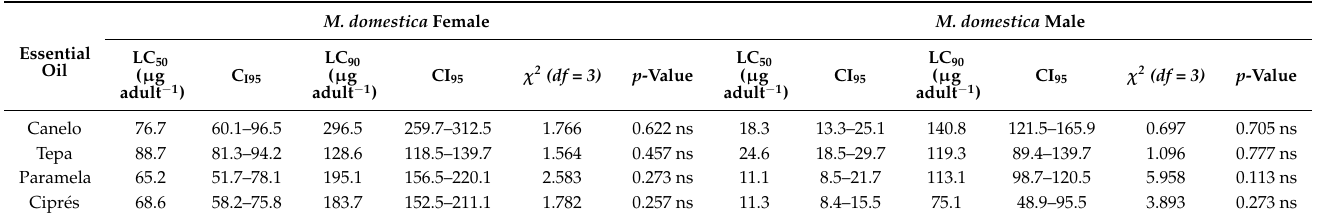
Table 2. Insecticidal activity of the four essential oils from Patagonian plants against adults (females and males) of Musca domestica; df = degrees of freedom, ns = not significant (p > 0.05) .